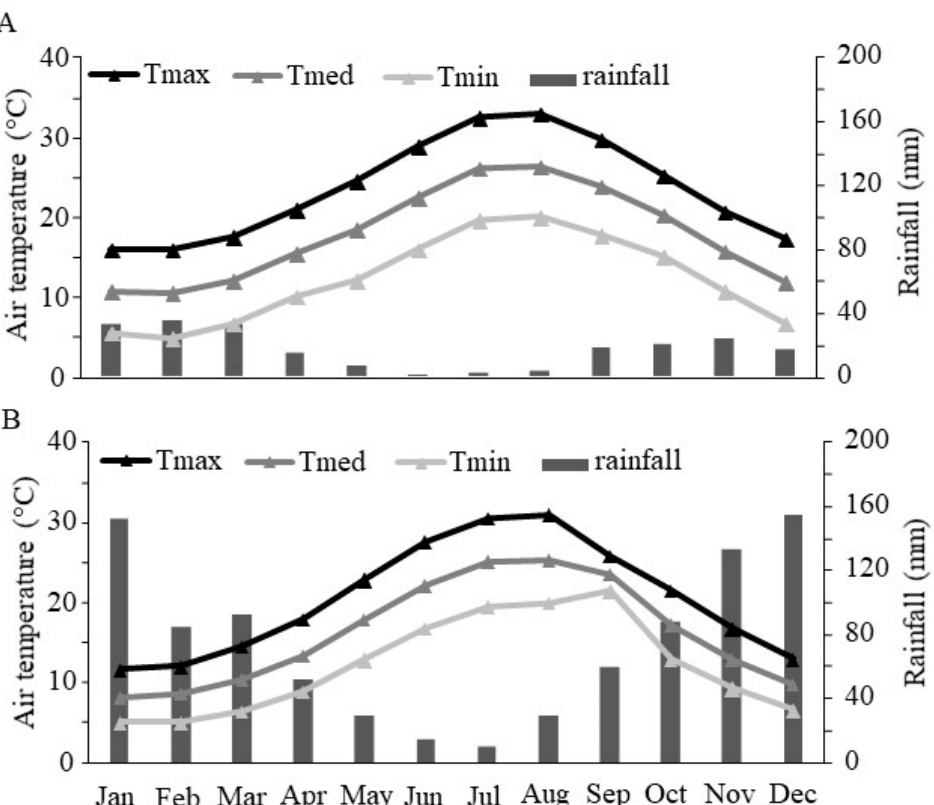
Figure 1. Monthly minimum, mean and maximum air temperatures and rainfall registered in the experimental field 1 (10 m a.s.l) ( A ) and experimental field 2 (850 m a.s.l.) ( B ). Data were calculated over a 30 year period from 1985 to 2014. Daily data over the same period are provided in Supplementary Table S2. Climatic data were provided by the Sicilian Water Observatory (www.osservatorioacque.it (accessed on April 2019)).